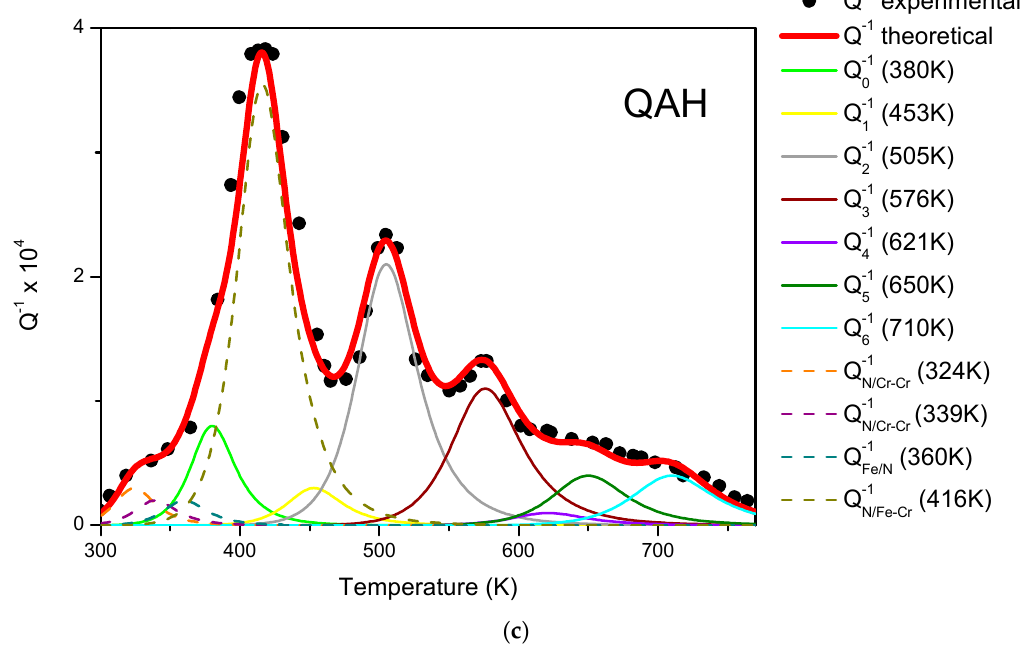
Figure 8. Q − 1 spectra of the steel, quenched and H-permeated ( QH ), quenched and annealed ( QA ), quenched, and annealed and H-permeated ( QAH ). Experimental data are reported after background subtraction.